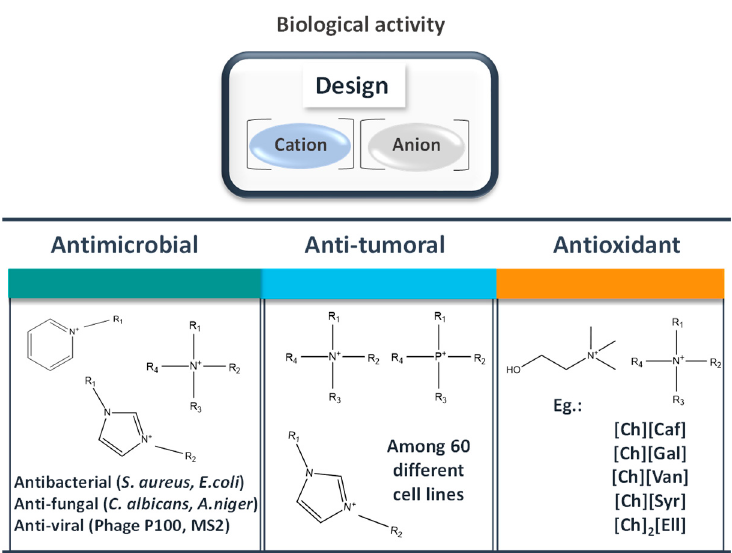
Figure 9. Biological activities reported for ILs and the respective studied cations (adequate references are given along the current section).